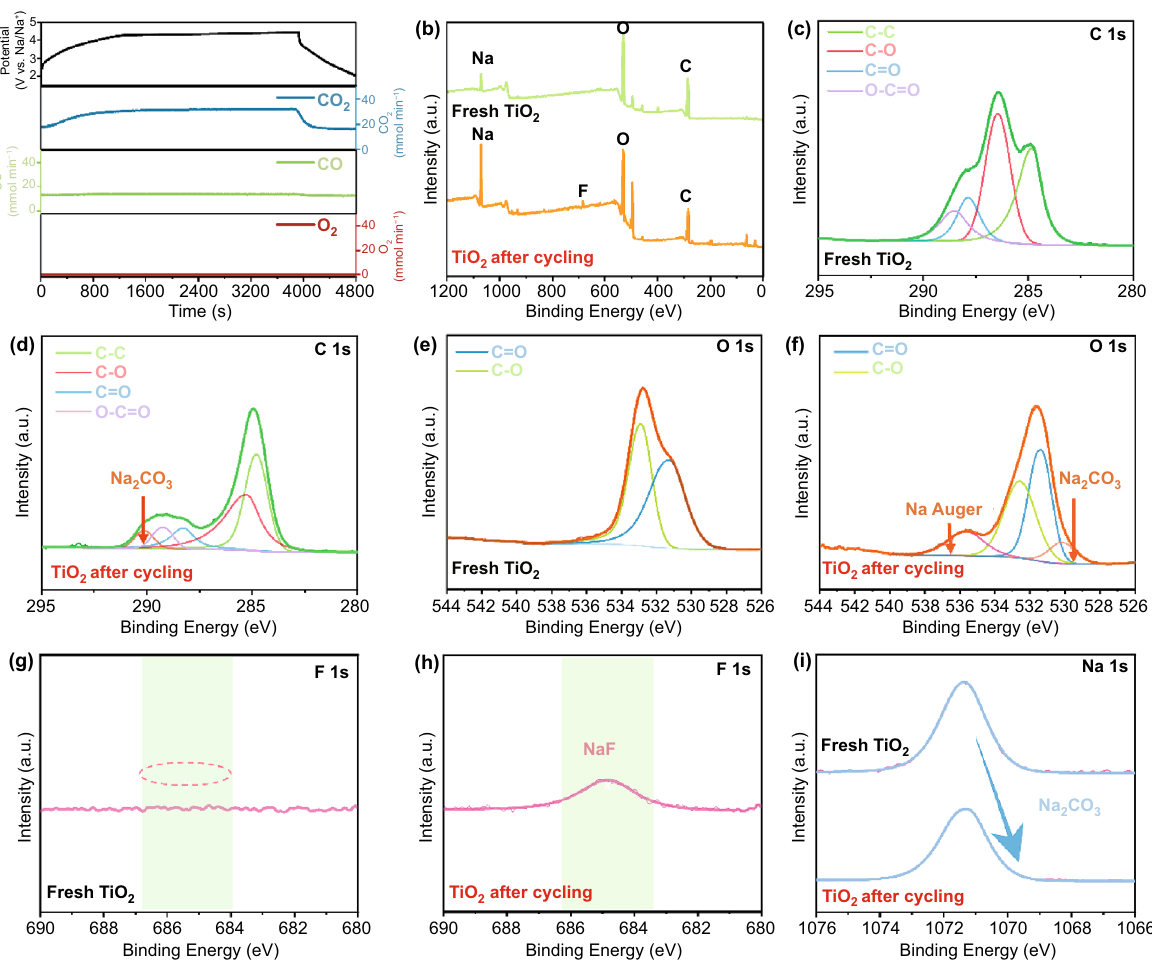
Fig. 7 a Gas evolution of Na 2 C 2 O 4 in DEMS test. b XPS survey spectrum TiO 2 anode before and after cycling. C 1s high-resolution of TiO 2 anode before ( c ) and after cycling ( d ). O 1s high-resolution of TiO 2 anode before ( e ) and after cycling ( f ). F 1s high-resolution of TiO 2 anode before ( g ) and after cycling ( h ). i Na 1s high-resolution of TiO 2 anode before and after